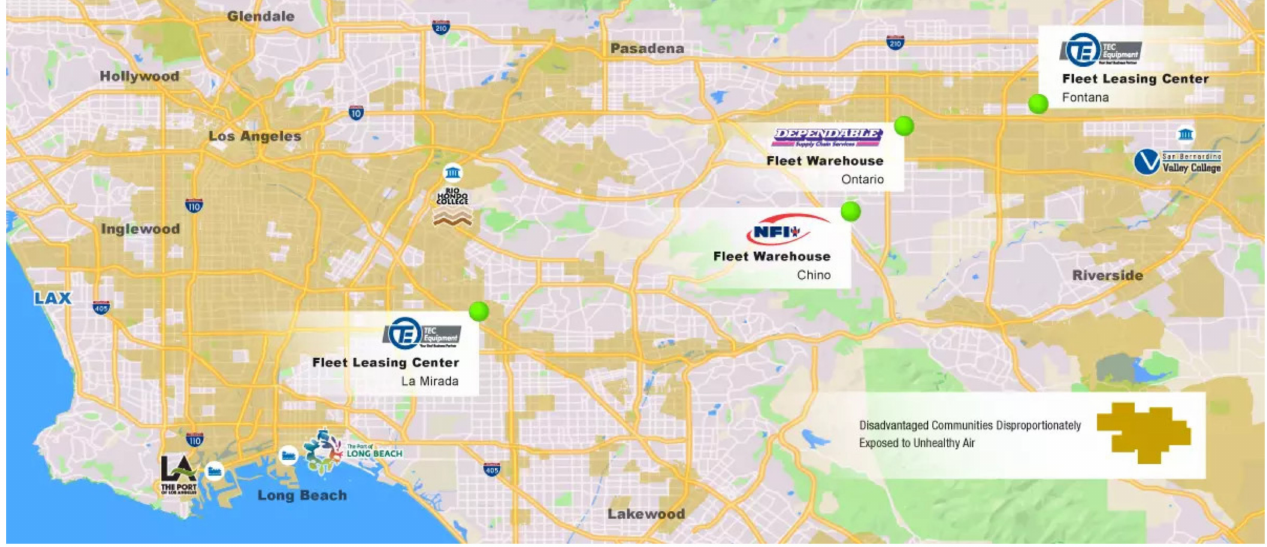
Figure 1. The Volvo LIGHTS project is taking place throughout the greater Los Angeles